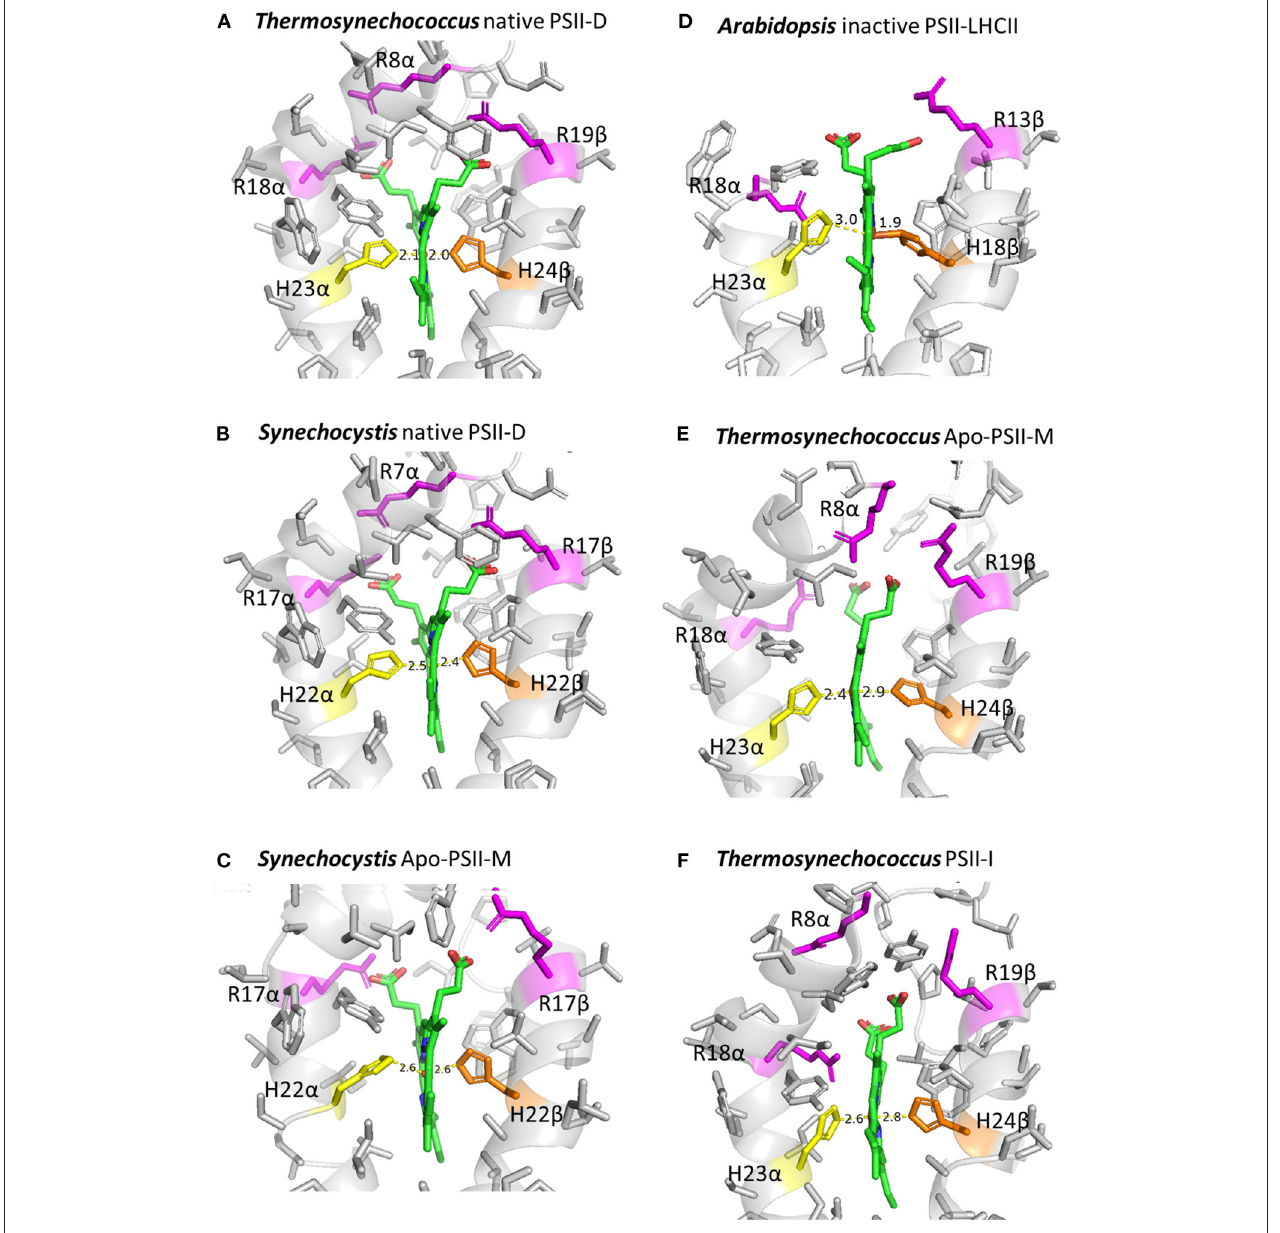
FIGURE 2 | Heme coordination environments of Cyt b 559 in cryo-EM structural models of different types of PSII preparations. (A) Native PSII dimer (PSII-D) of Thermosynechococcus (PDB 7D1U); (B) native PSII-D of Synechocystis (PDB 7RCV); (C) inactive PSII monomer (Apo-PSII-M) of Synechocystis (PDB 6WJ6); (D) inactive PSII-LHCII supercomplex from Arabidopsis (PDB 7OUI); (E) Apo-PSII-M of Thermosynechococcus (PDB 7NHO); and (F) PSII assembly intermediate (PSII-I) of Thermosynechococcus (PDB 7NHP). The figures were created using